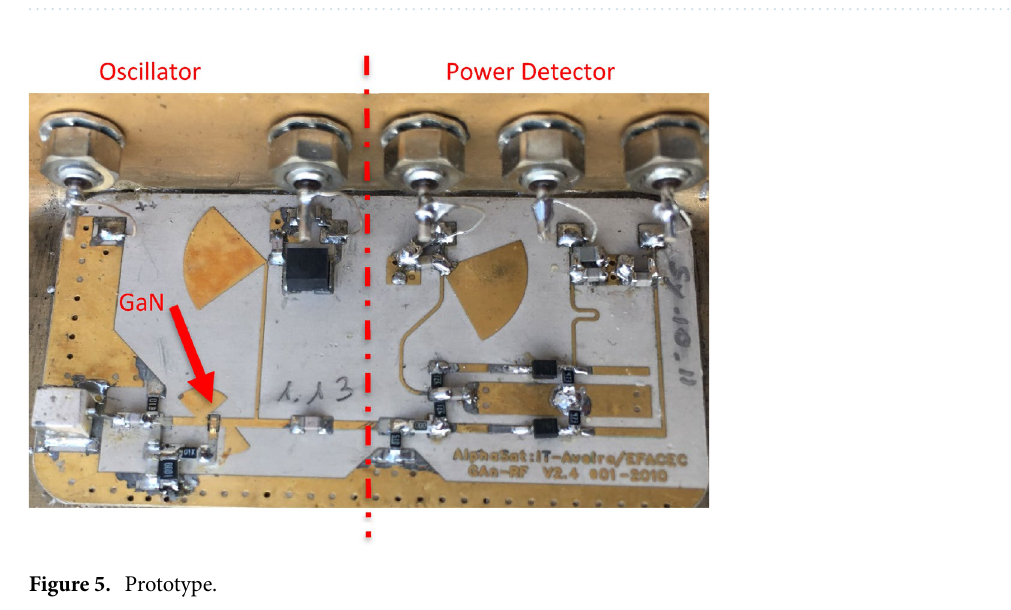
Figure 4. Oscillator schematic.